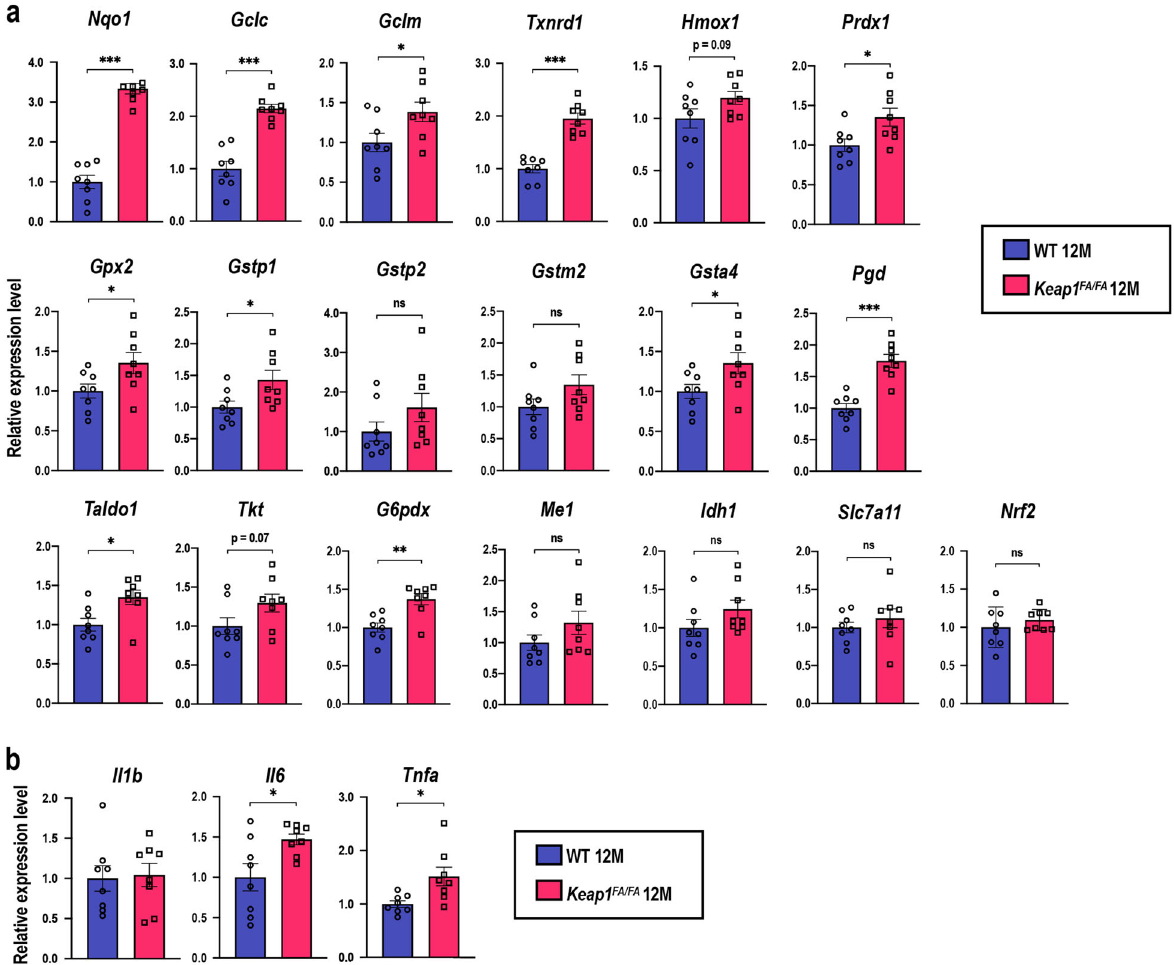
Fig. 10 Gene expression in the WT and Keap1 FA/FA cochleae at 12 months of age. Expression levels of NRF2 target genes and Nrf2 ( a ), and proin fl ammatory cytokine genes ( b ) in whole cochleae were evaluated by quantitative real-time PCR ( n = 8 in each group). All the samples were quanti fi ed by using the same standard curve and each expression level was normalized to the Hprt or Beta-Actin expression level. Average expression levels of WT cochlea are set as 1. The data represent the mean ± SEM. * P < 0.05, ** P < 0.01, *** P < 0.001. Unpaired two- tailed Student ’ s t -test was applied. A part of data on the WT mice at 12 months of age are the same as those shown in Fig.